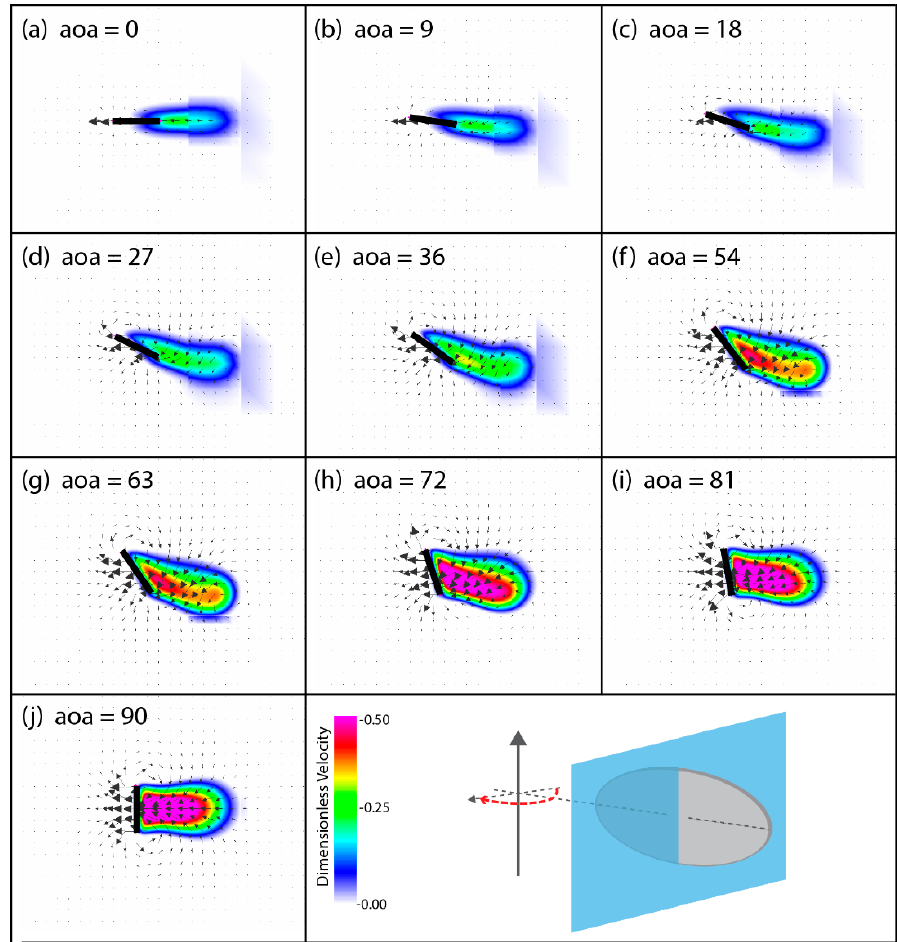
Figure 12. The vector fields and spanwise flow at mid-stroke obtained from three-dimensional computational simulations ( Re = 128, angle of attack range from 0° to 90°). The cross-section shown is through the chord at the midpoint of the span. The vectors show the direction of flow and are scaled to the magnitude of the flow velocity. The color map shows the spanwise flow (min = 0 and max = 0.5) in the direction normal to the plane. Note that the wing is traveling to the left.